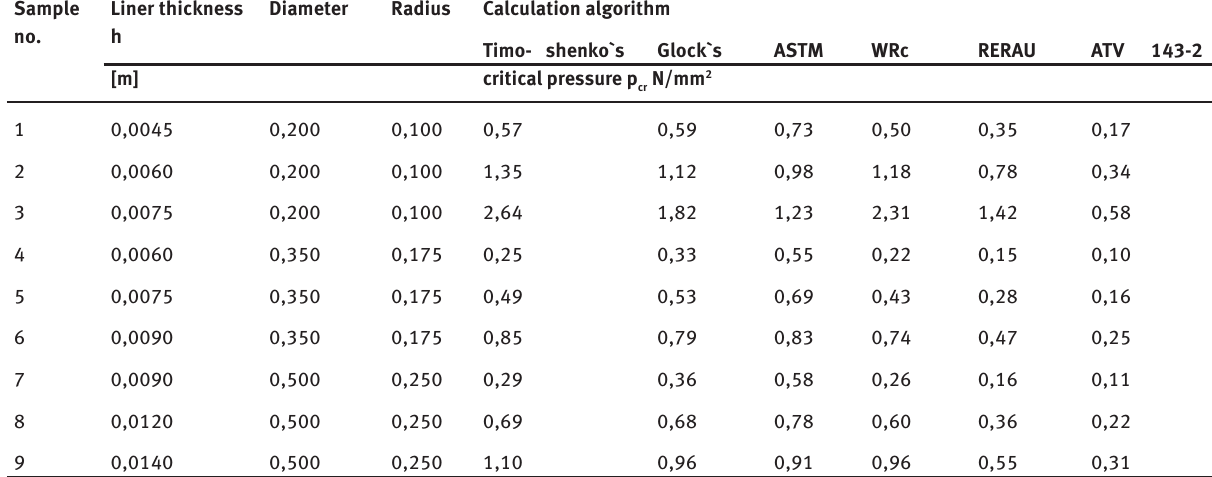
Table 2: Results of calculation algorithm.